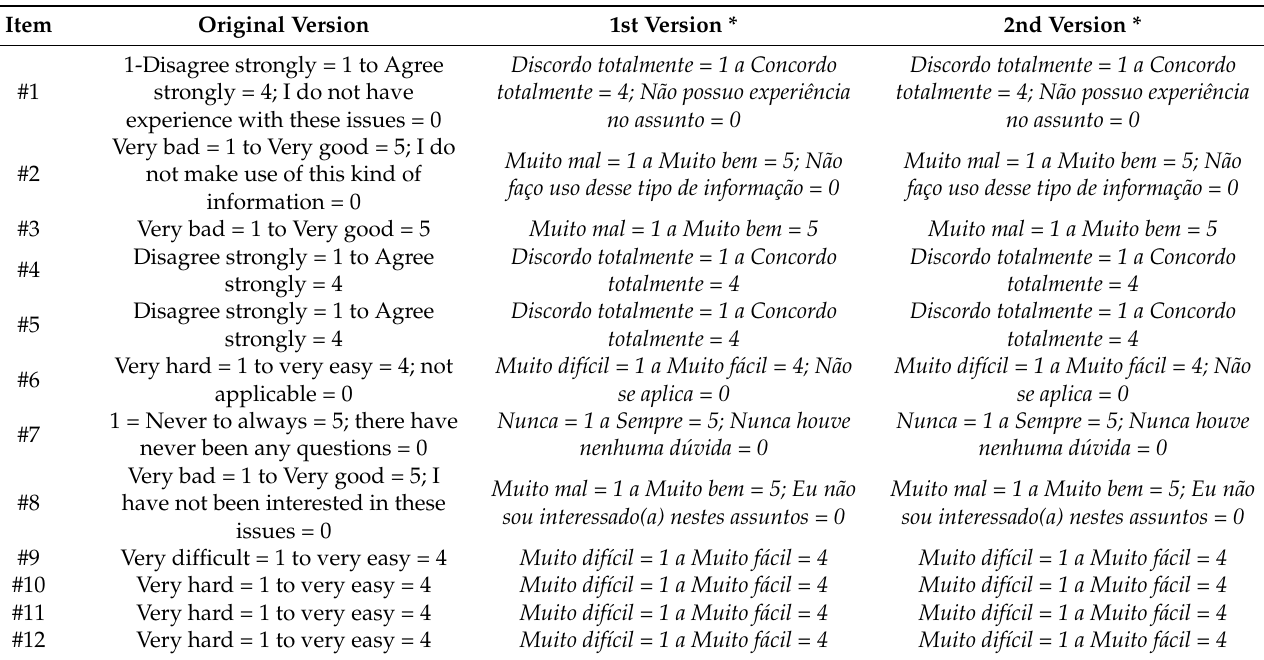
Table 2. Response scales of each item of the original version of the SFLQ and the 1st version and 2nd version of the